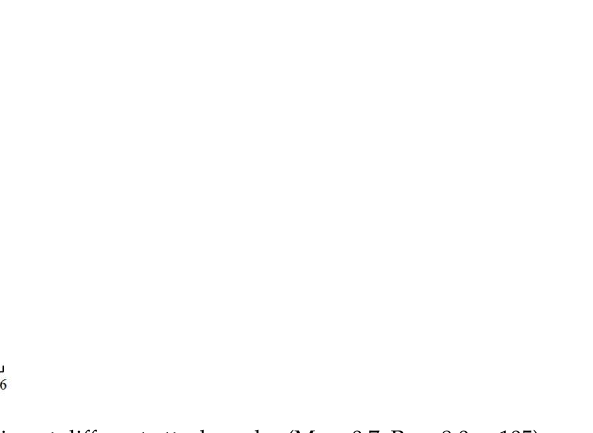
( f ) Helium, i = 3 Figure 12. Representations of suction surface skin ‐ friction lines under different attack angle (Ma = 0.7).